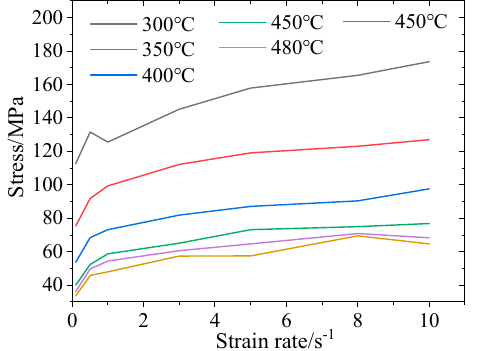
Figure 5. The influence of the strain rate on steady flow